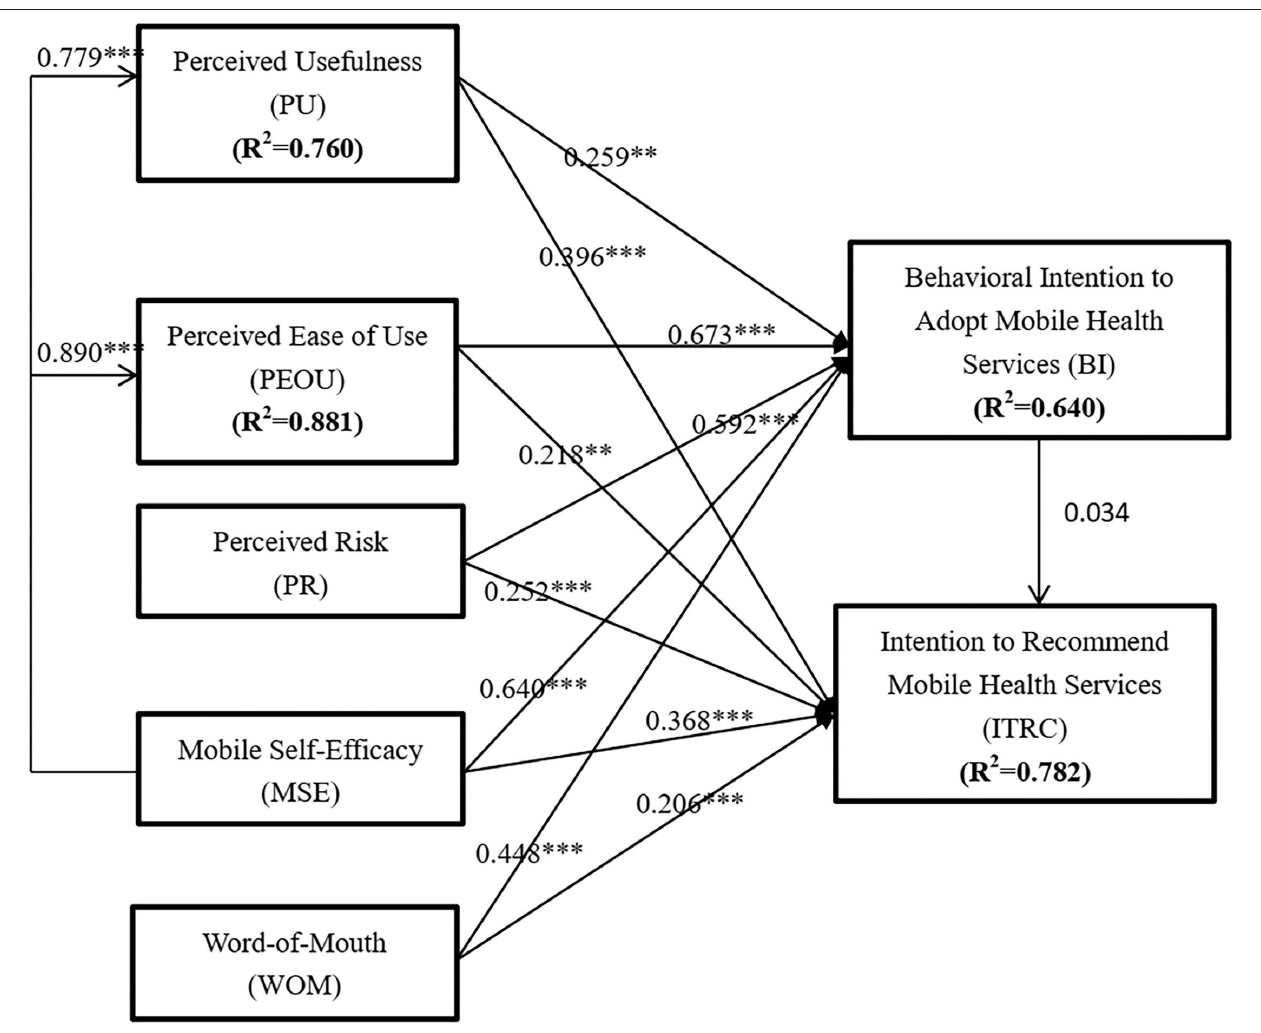
FIGURE 2 | Validated structural